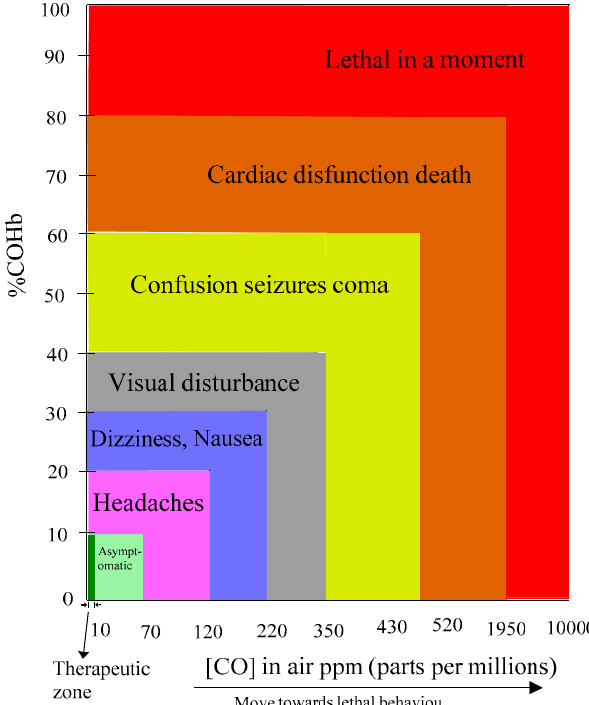
Figure 3. The carboxy hemoglobin (COHb) percentage is increasing in the direct CO inhalation beyond the therapeutic zone (~10%) during the mainstream blood circulation. (This information is based on data reported in reference [44,45]).